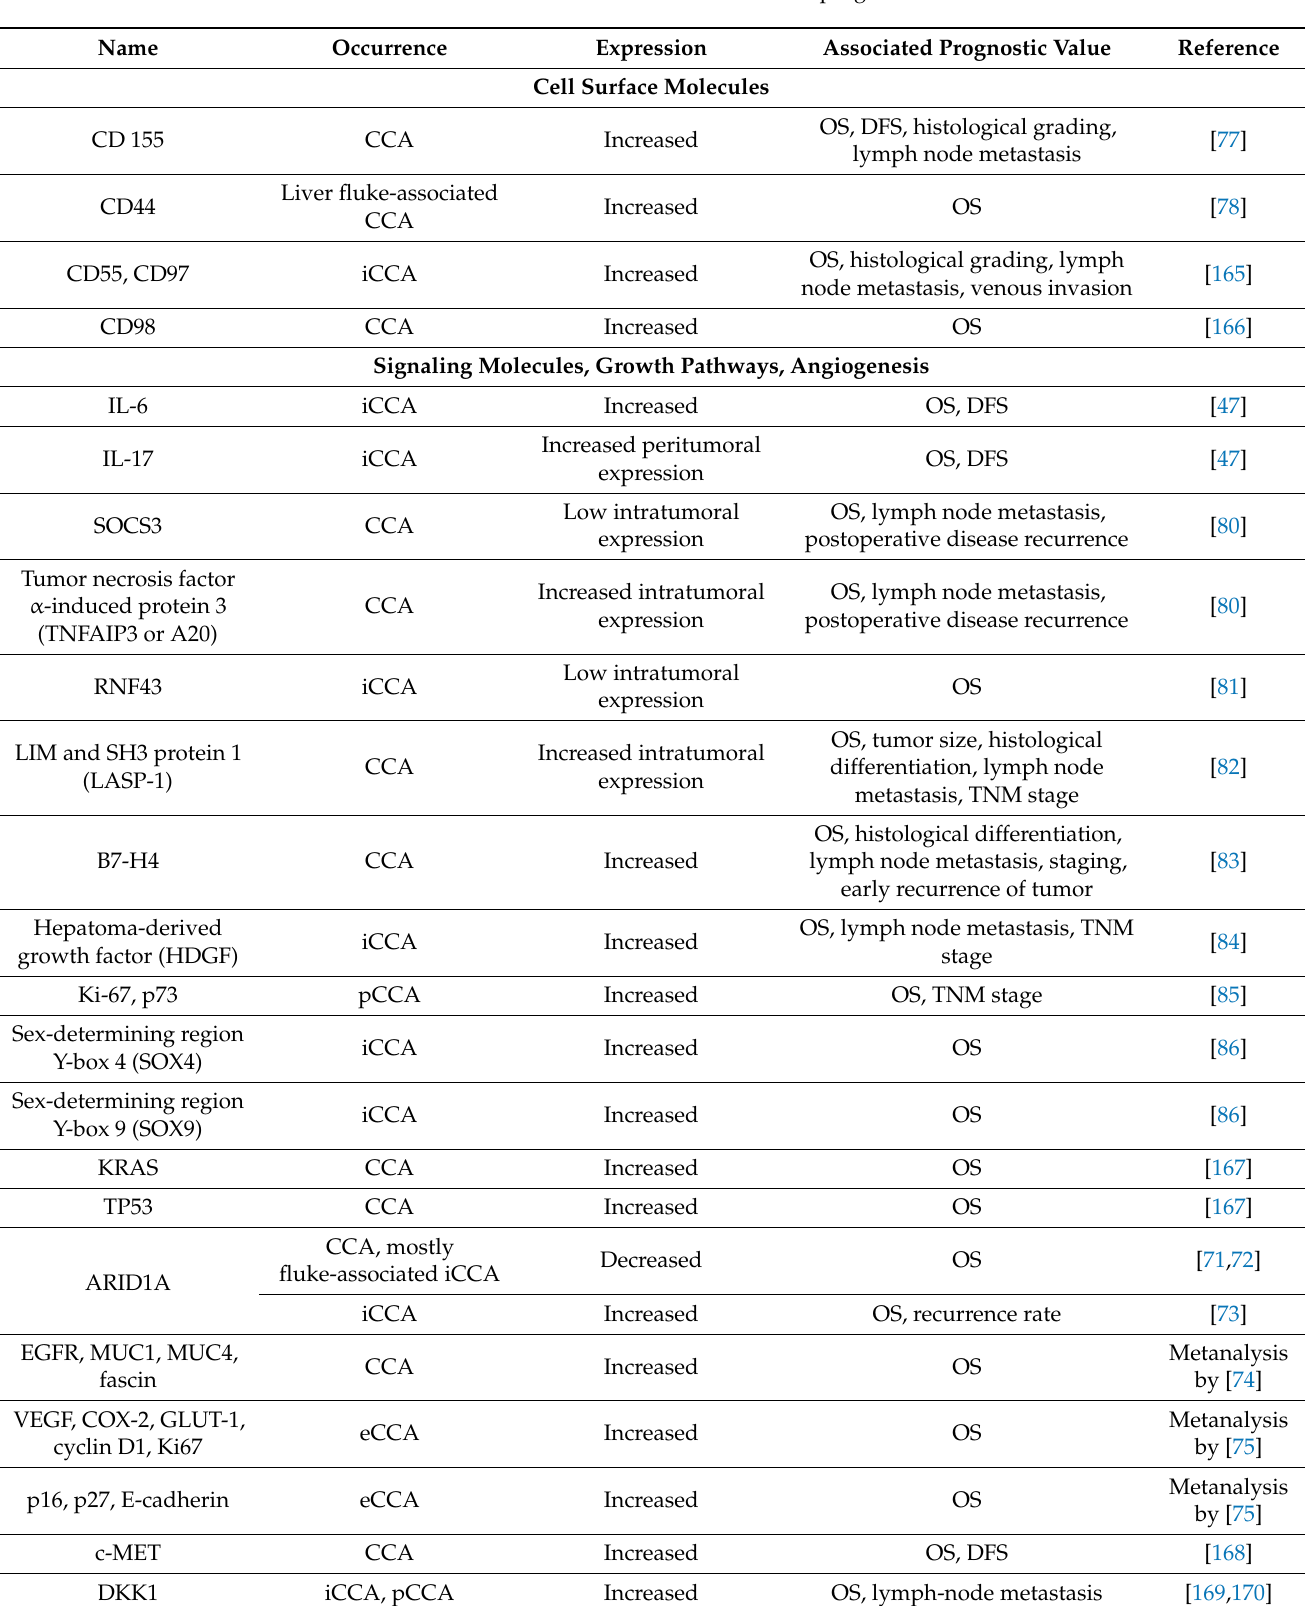
Table 2. Tumor tissue biomarkers associated with prognosis in